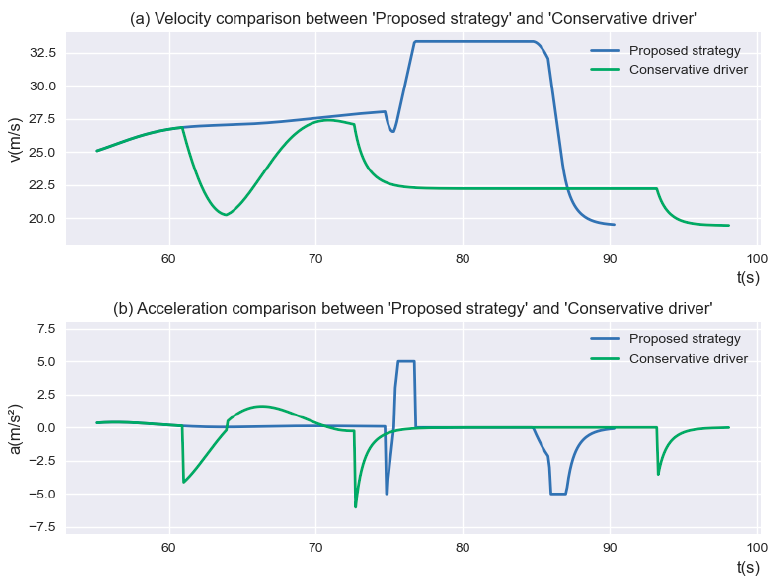
Figure 7. The position, lateral acceleration and trajectories of “Proposed strategy” during two lane- changing processes.